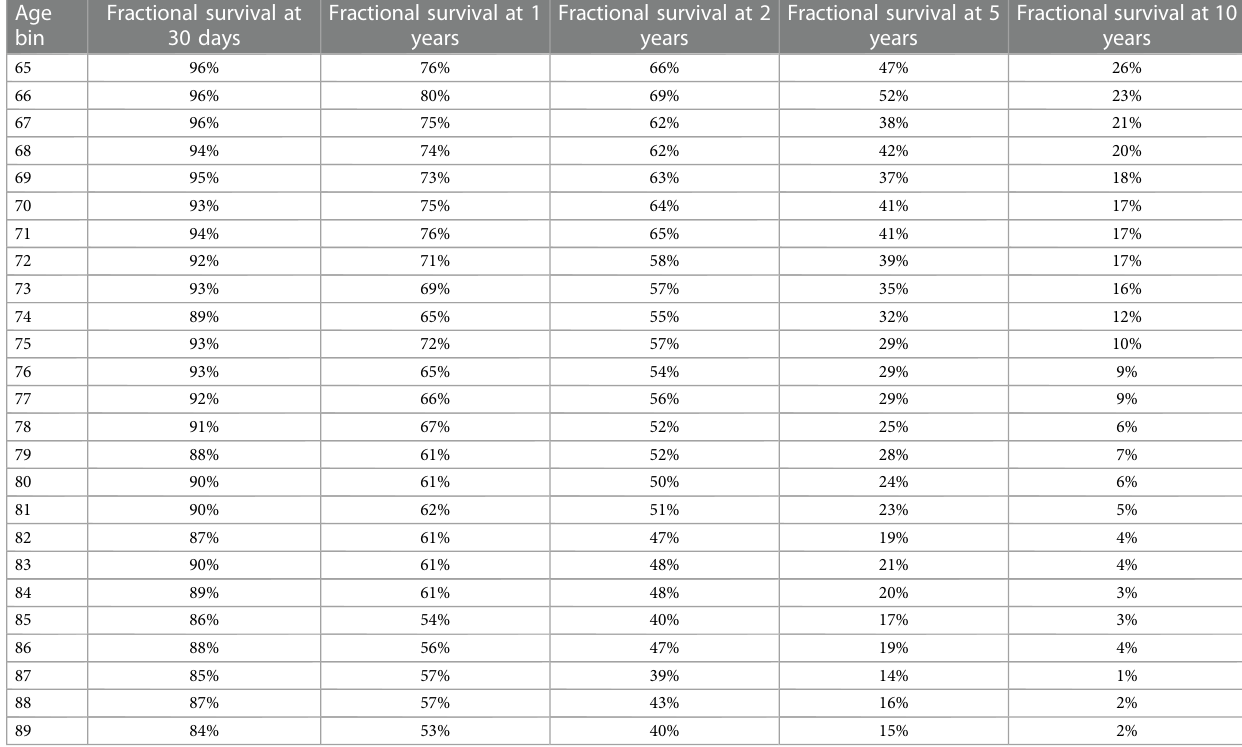
TABLE 2 Fractional survival by age in the RULE cohort, n